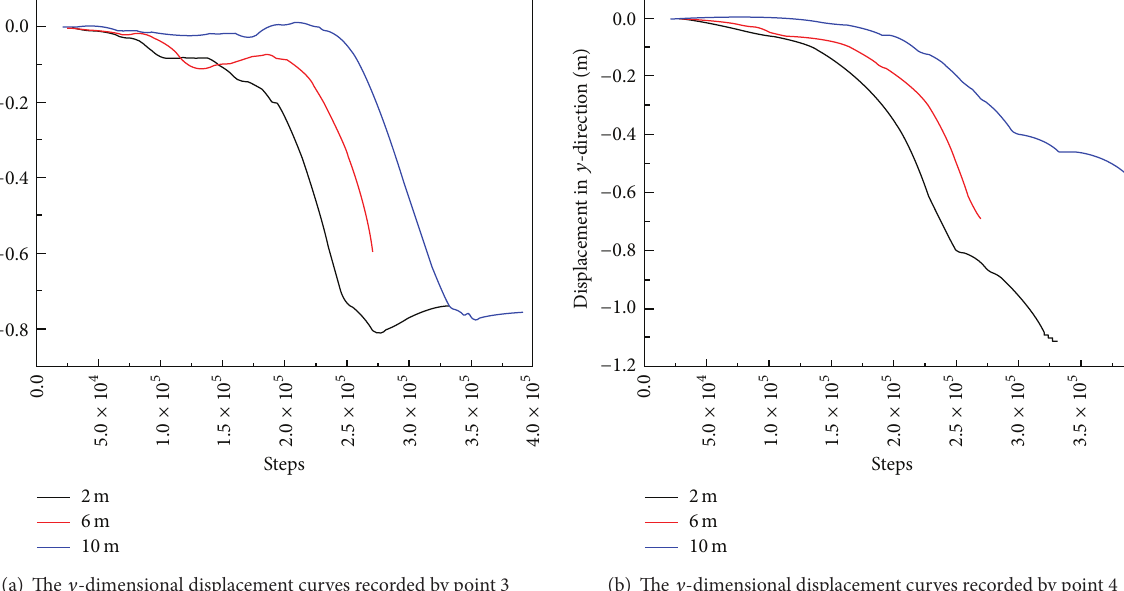
Figure 8: The changing curves of y -dimensional displacements of monitoring points 3 and 4. 2 m, 6 m, and 10m in legend represent the immediate roof thickness,